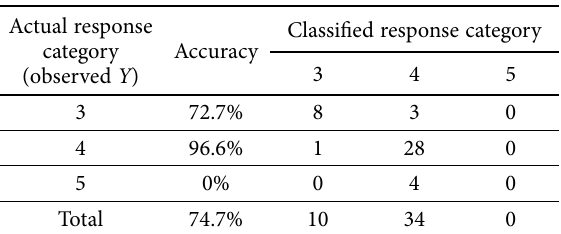
Table 5. Accuracy of the classification for response categories based on the regression model in logit link with 3 grouped